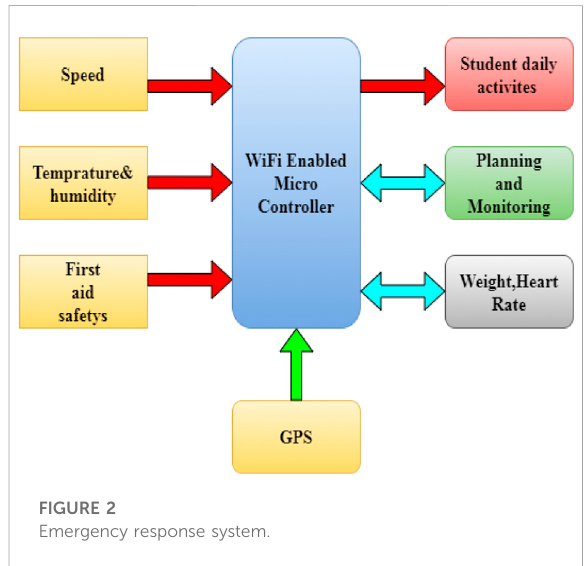
FIGURE 2 Emergency response